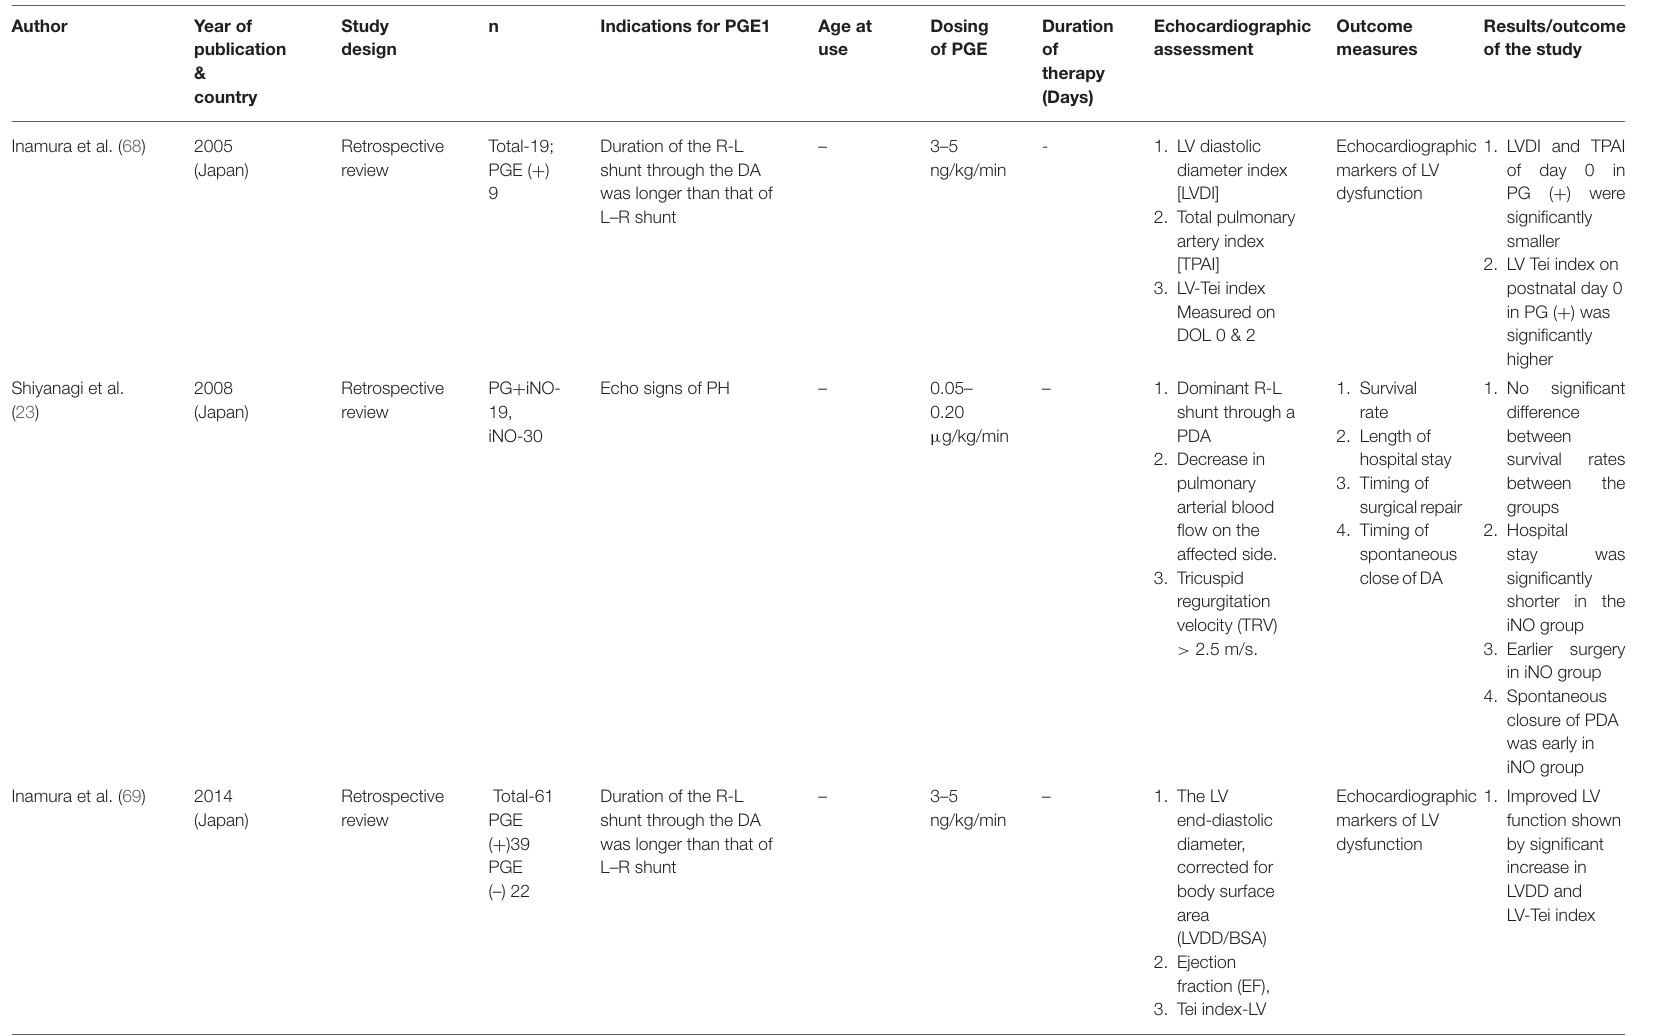
TABLE 1 | Summary of clinical studies on PGE1 use in